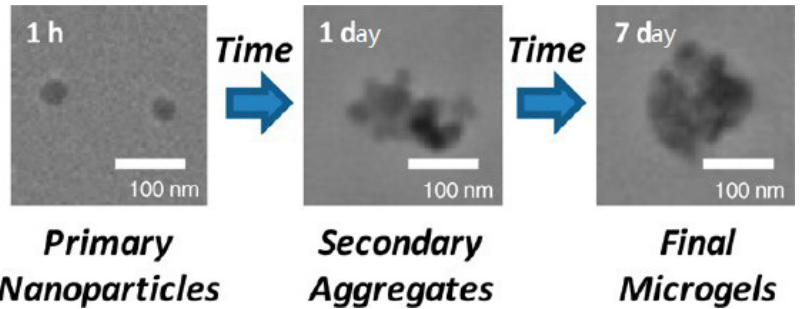
Figure 5. Formation of chitosan-tripolyphosphate (TPP) microgels via salt-assisted mechanisms. The final micro-gel is formed by a controlled aggregation of primary nanoparticles into larger coacervates. Adapted with permission from [23], Copyright 2012 American Chemical Society.